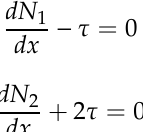
Figure 3. Free body diagram for an infinitesimal segment dx.